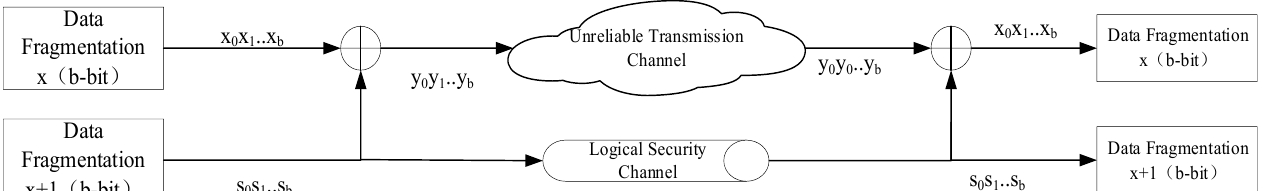
Figure 1. Multi-connection Encryption Transmission